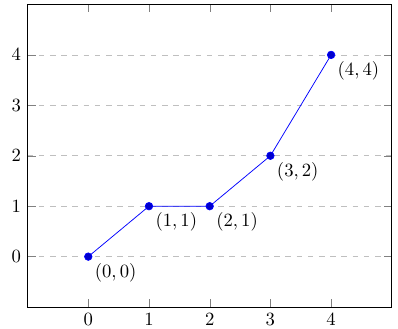
Figure 1: Piecewise linear function defined by L